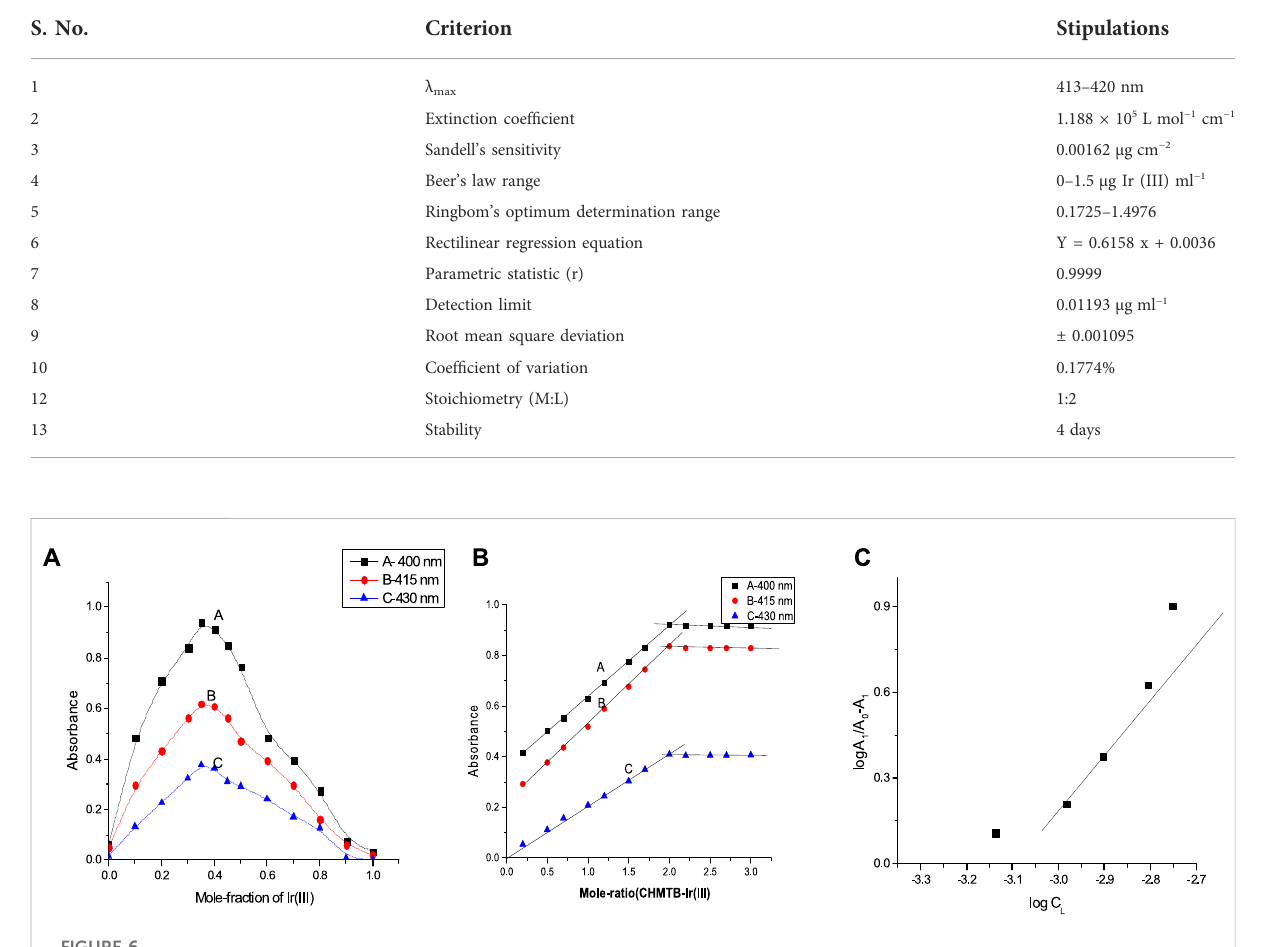
FIGURE 6 Determination of the composition of the complex (A) Job ’ s continuous variations method, (B) mole-ratio method, and (C) equilibrium shift